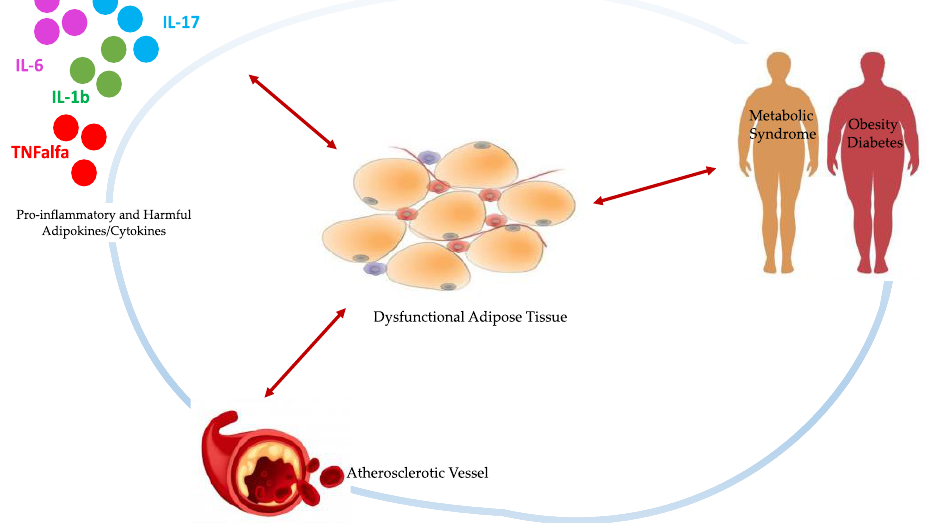
Figure 1. Schematic representation of bidirectional signaling between dysfunctional EAT and dam- aged vasculature, pro-inflammatory cytokines and stressful/pathological conditions, all intercon- nected by subtle cause-and-effect relationships. Physiologically, EAT contributes to maintaining vessels homeostasis through the production of anti-inflammatory adipokines and cytokines in re- sponse to the same markers of oxidative stress and inflammation from the vasculature. When stressful conditions take over, the EAT becomes hypertrophic and dysfunctional, releasing detrimental substances which contribute to the onset and progression of atherosclerosis.